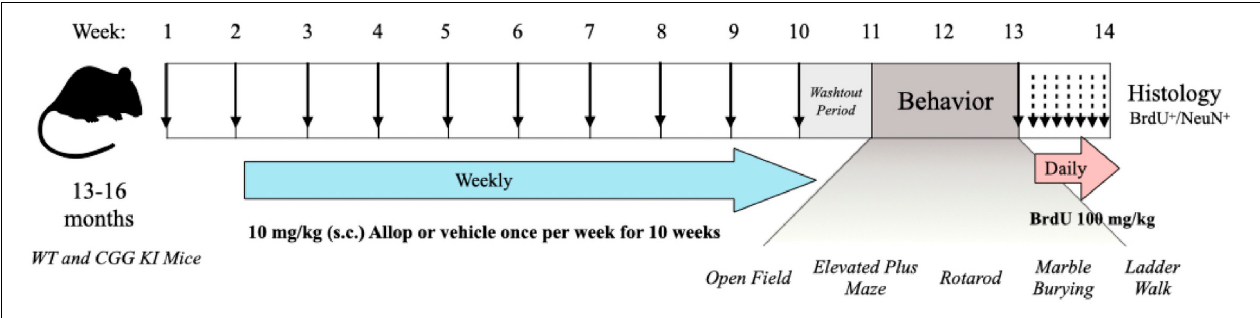
FIGURE 1 | Timeline for the experimental procedures. WT and CCG KI mice between the ages of 13–16 months old were treated once weekly with allopregnanolone (Allop) (10 mg/kg s.c.) or β -cyclodextrin vehicle control. Following the last injection, mice were left undisturbed for a 1-week drug washout period and then assessed for behavioral differences across a battery of motor and arousal tasks. Then, mice were injected once daily with 5-bromo-2 (cid:48) -deoxyuridine (BrdU, 100 mg/kg i.p.) for seven consecutive days and their brains were then processed for evidence of